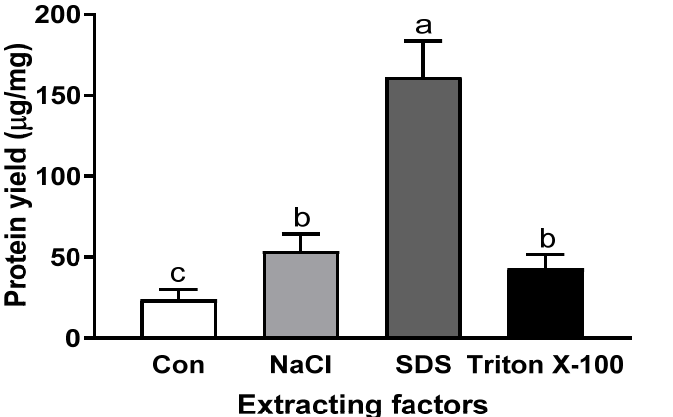
Figure 5. Protein extraction yield of sous vide-cooked abalone with various optimal extraction factors, including 0.6 M NaCl, 16 mM SDS, and 0.8 mM of Triton X-100. Bars with different letters are significantly different ( p < 0.05).